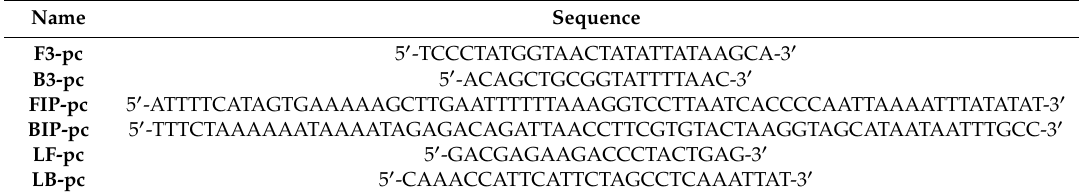
Table 2. LAMP 16S rRNA primer sequences for positive control of L. vulgaris .